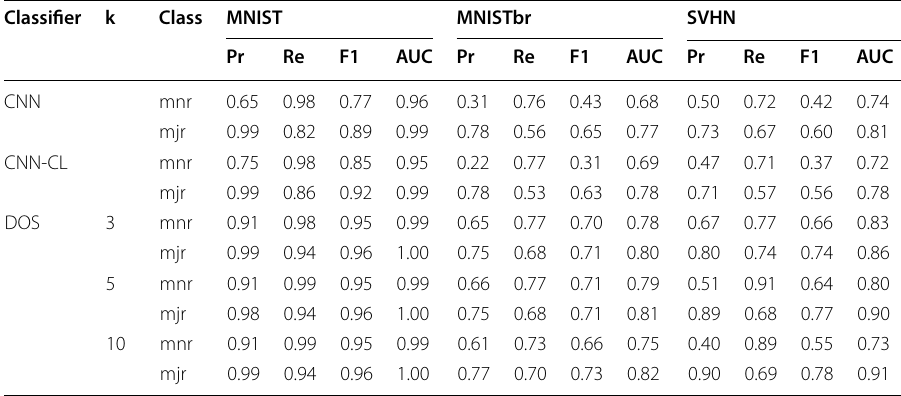
Table 15 DOS with varying k [117] Classifier